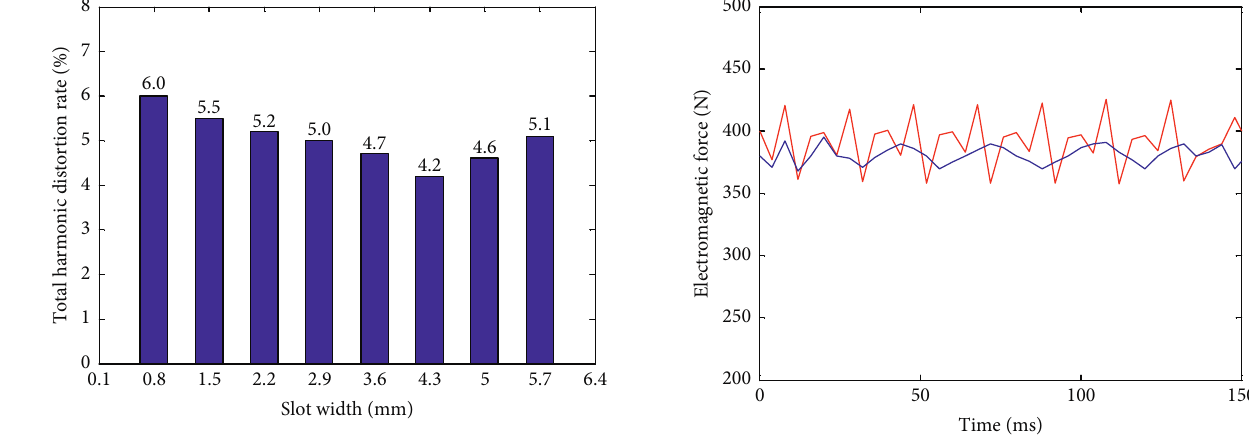
Figure 10: Changes of total harmonic distortion rate with slot